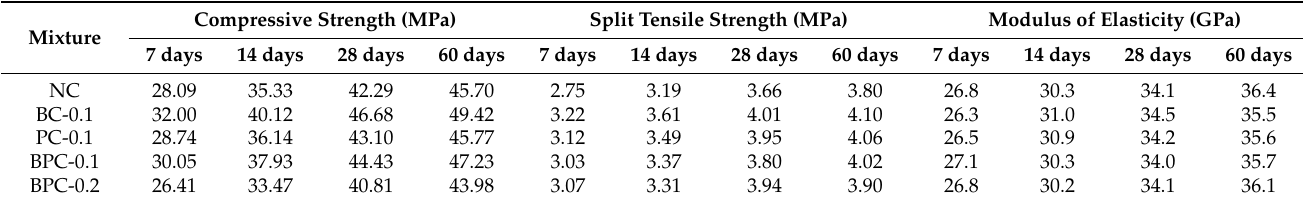
Table 4. Mechanical properties of the HBPRC.